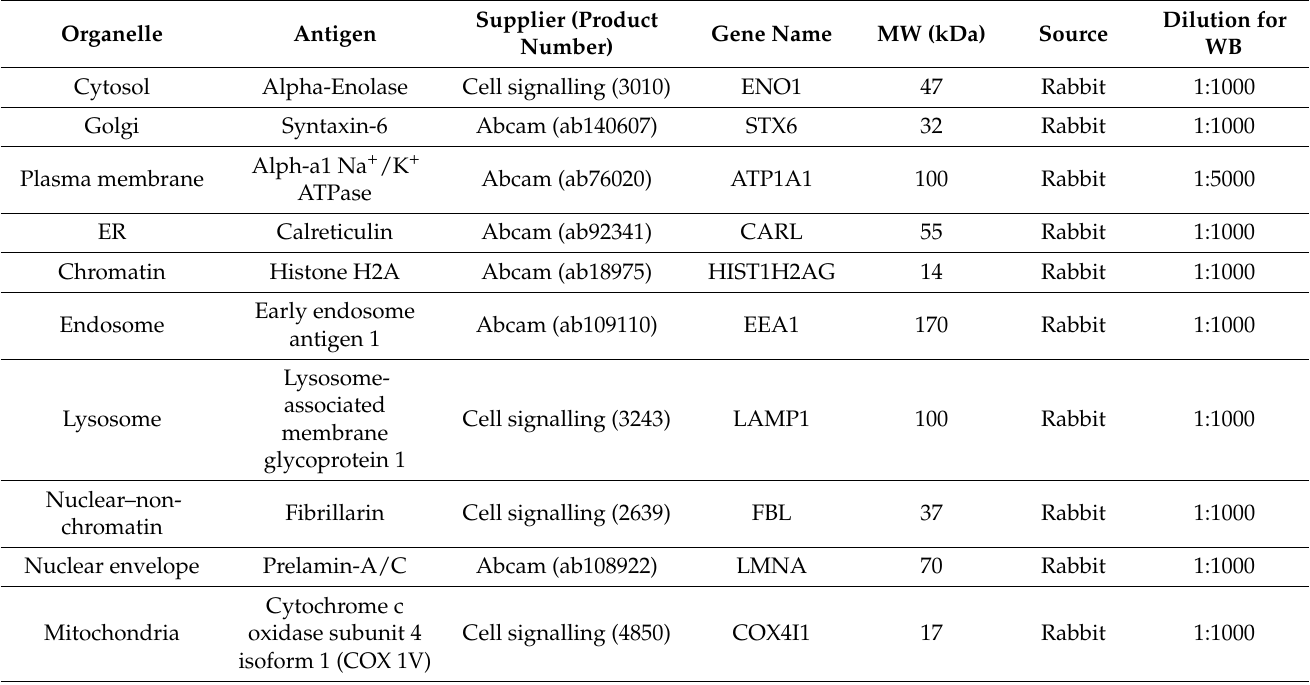
Table 2. List of antibodies for evaluating organelle-specific marker proteins used to evaluate organelle separation via differential centrifugation in LOPIT-DC workflow. All the antibodies listed (with the exception of the antibody to detect the PM marker) were kindly provided by Professor Lilley’s lab at the University of Cambridge (Department of